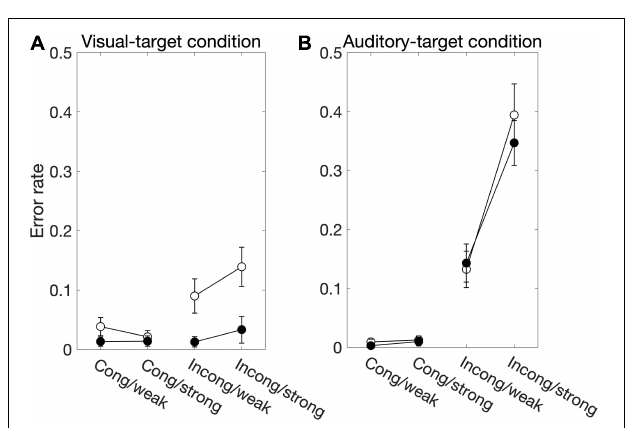
FIGURE 3 | The factors influencing the error rate for the visual-target condition (A) and the auditory-target condition (B) . White and black circles indicate the weak and strong targets, respectively. For the statistical comparison of the factors, see Tables 2 , 4 . Generally, these results show effects similar to those in the SRT